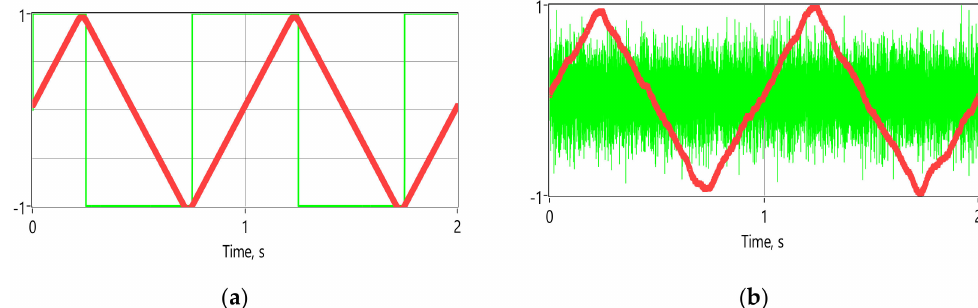
Figure 11. Normalized results of the di ff erential sampling solution: without added noise ( a ), and the same signals with 0.1 mV noise added (typical situation during EBI acquisition) ( b ); all the curves are normalized for better